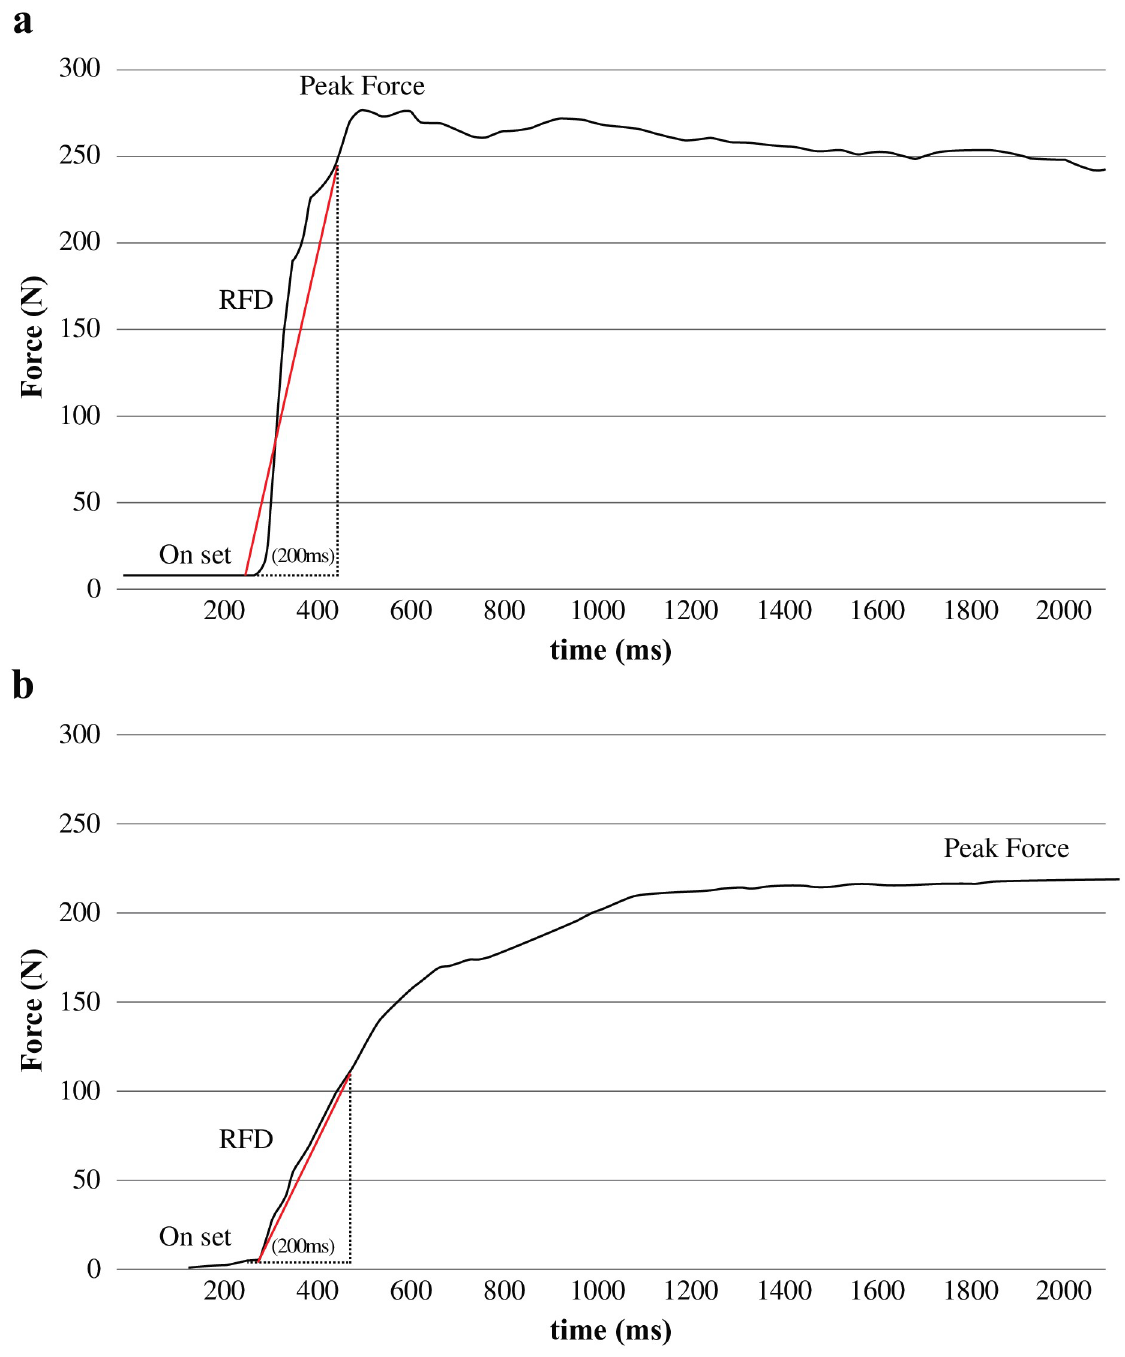
Fig 2. (a) Isometric force-time curve indicating the maximum strength and RFD in individuals with mild KOA. (b) Isometric force-time curve indicating the maximum strength and RFD in individuals with severe KOA. KOA; knee osteoarthritis; RFD; rate of force